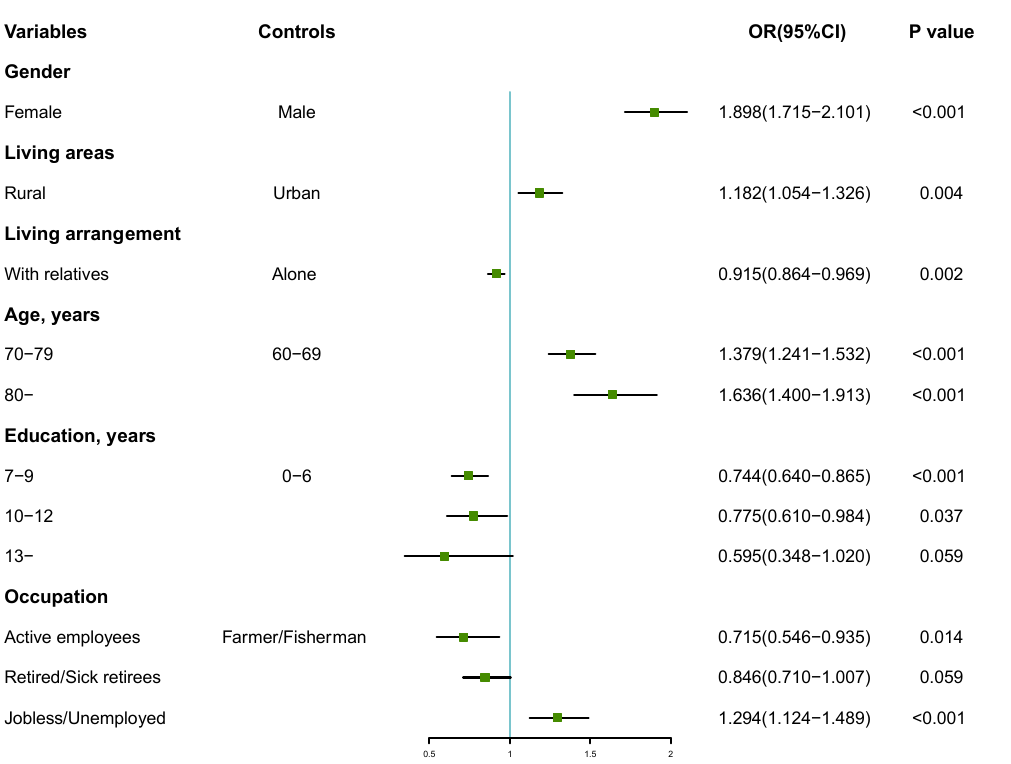
Figure 3. Forest plot of dichotomous multi-factor logistic regression analysis of factors influencing sleep quality among people aged 60 years and above in Shandong province in 2015. OR: odds ratio.